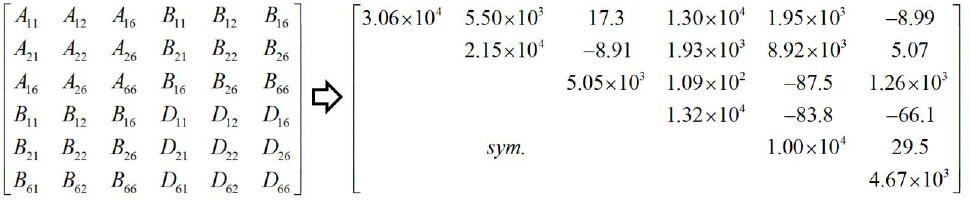
Figure 4. Effective plate properties of CCCP with layup configuration of [ 0/45/90/ − 45/0 ] s obtained by present